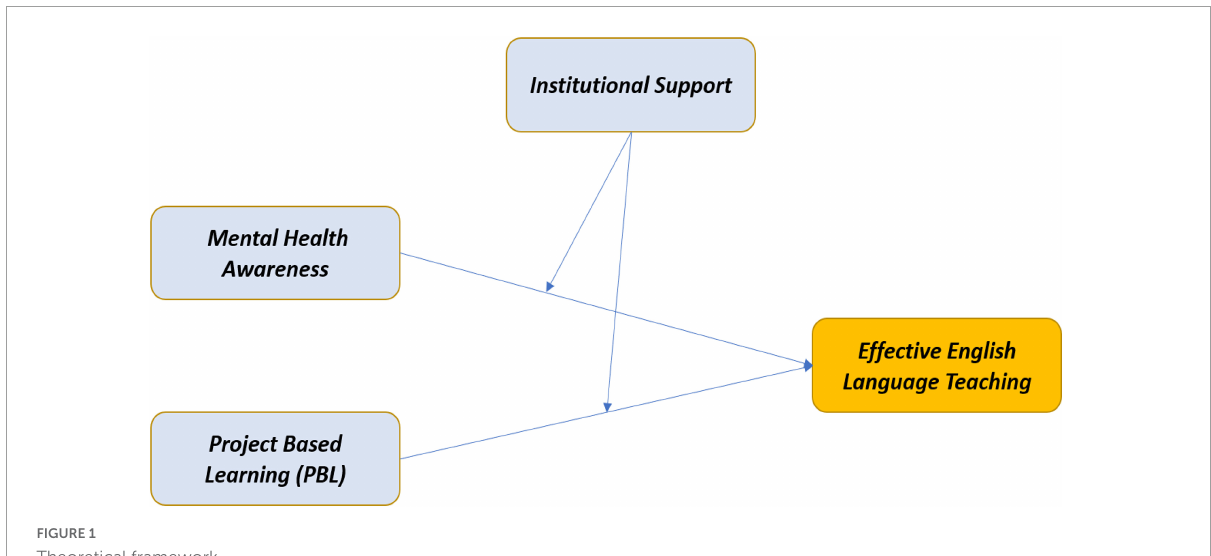
FIGURE1 Theoretical